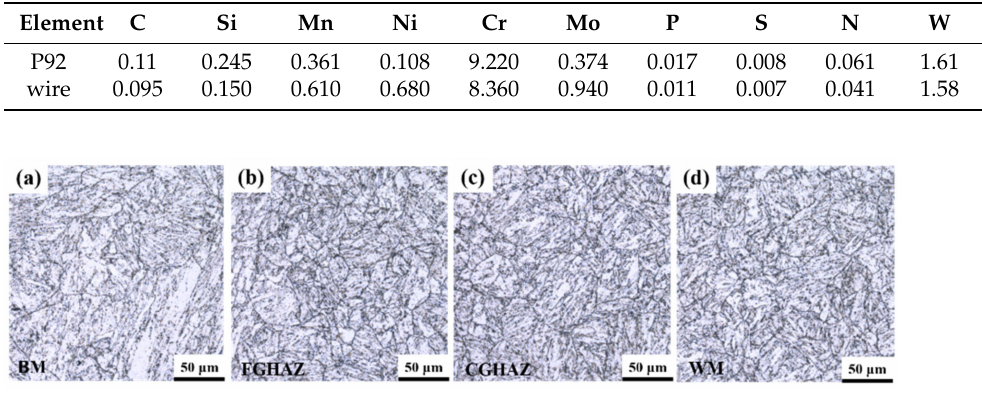
Figure 2. Microstructures in the ( a ) BM, ( b ) FGHAZ, ( c ) CGHAZ and ( d ) WM regions for P92 steel welded joint